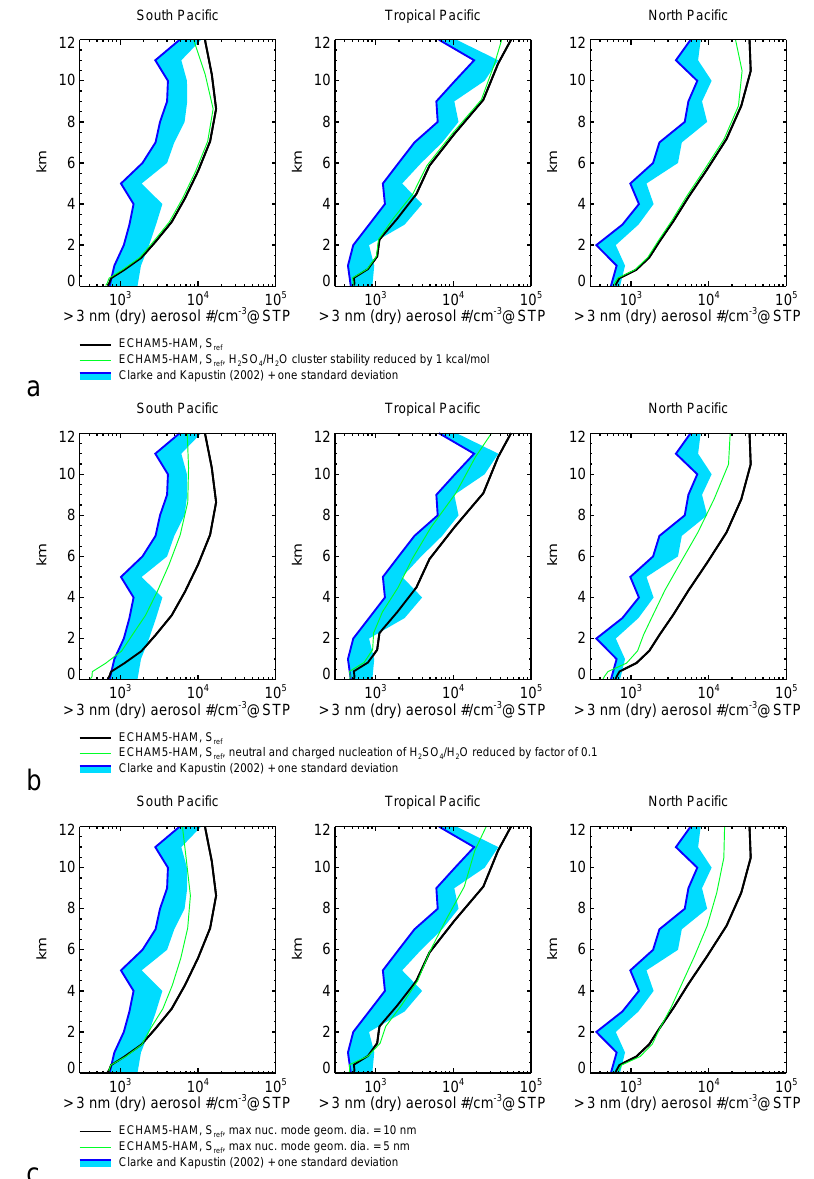
Fig. 4. Comparison of annual mean ultrafine aerosol concentrations from simulation S ref (black) with modifications (green) in three regions of the Pacific Ocean. (a) Stability of neutral and charged H 2 SO 4 /H 2 O clusters reduced by 1kcalmol − 1 . (b) Neutral and charged H 2 SO 4 /H 2 O particle formation rates reduced by a factor of 0.1. (c) Maximum geometric mean diameter for the nucleation mode in the M7 aerosol microphysics module reduced from 10 to 5nm.